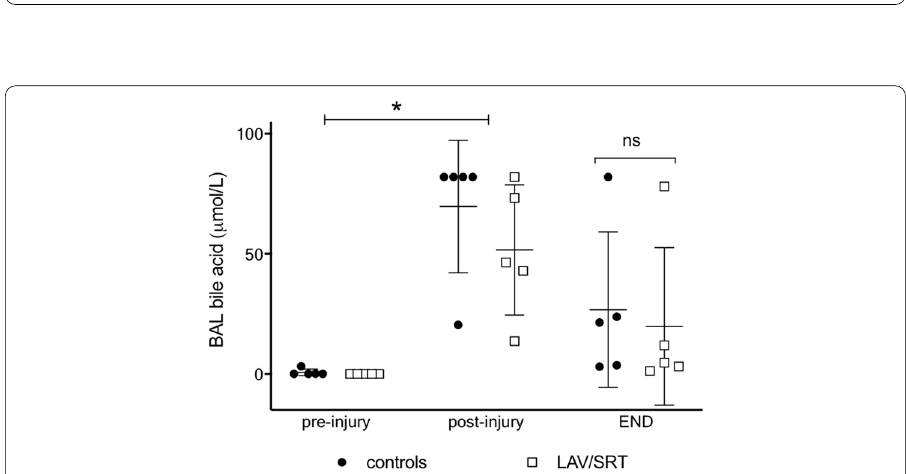
Fig. 5 Total bile acid concentration (µmol/L) measured from bronchoalveolar lavage (BAL) taken prior to injury with gastric juice (pre-injury), 2 h after injury (post-injury) and at the end of the experimental protocol (controls or LAV/SRT). Two-way ANOVA for repeated measures: * p < 0.05 pre-injury vs post-injury. Mann– Whitney test: p > 0.05 controls vs